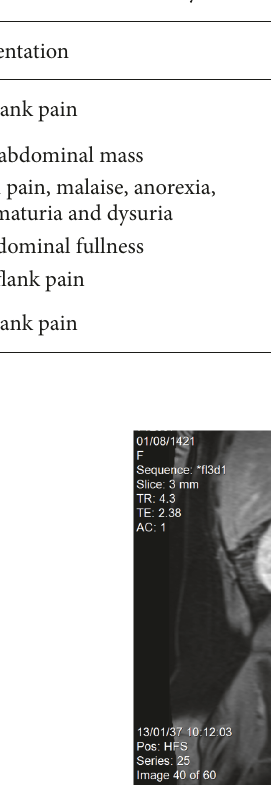
Table 1: Review of case reports of the occurrence of renal oncocytoma in pediatric patients.